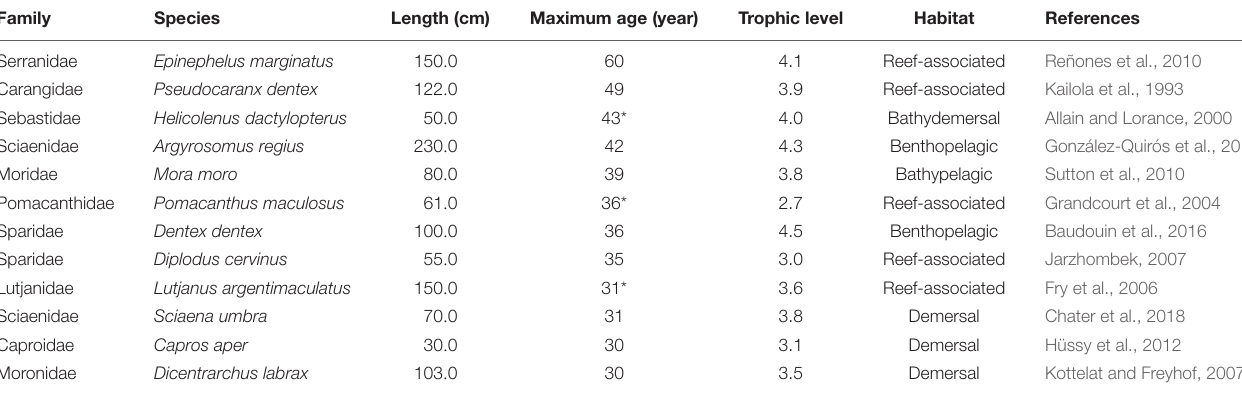
TABLE 2 | The list of long-lived fish species in the Mediterranean Sea according to FishBase. Data sorted by descending maximum reported age. Family Species Length (cm) Maximum age